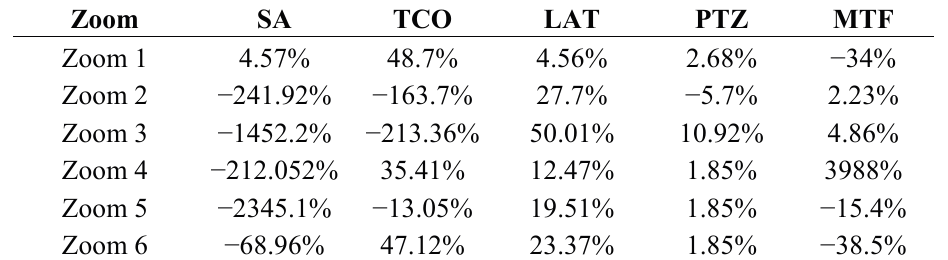
Table 7. Percentage comparison between the proposed lens and a standard 9× zoom